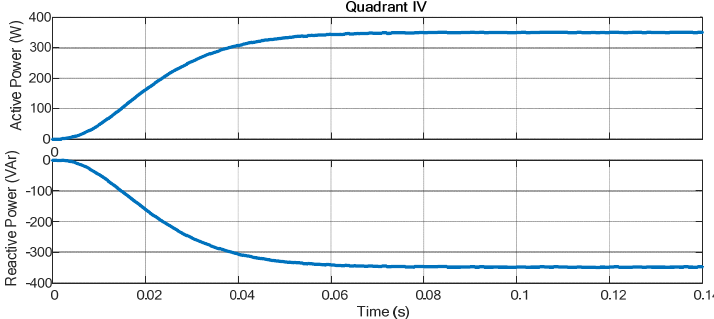
Figure 12. Quadrant 4.